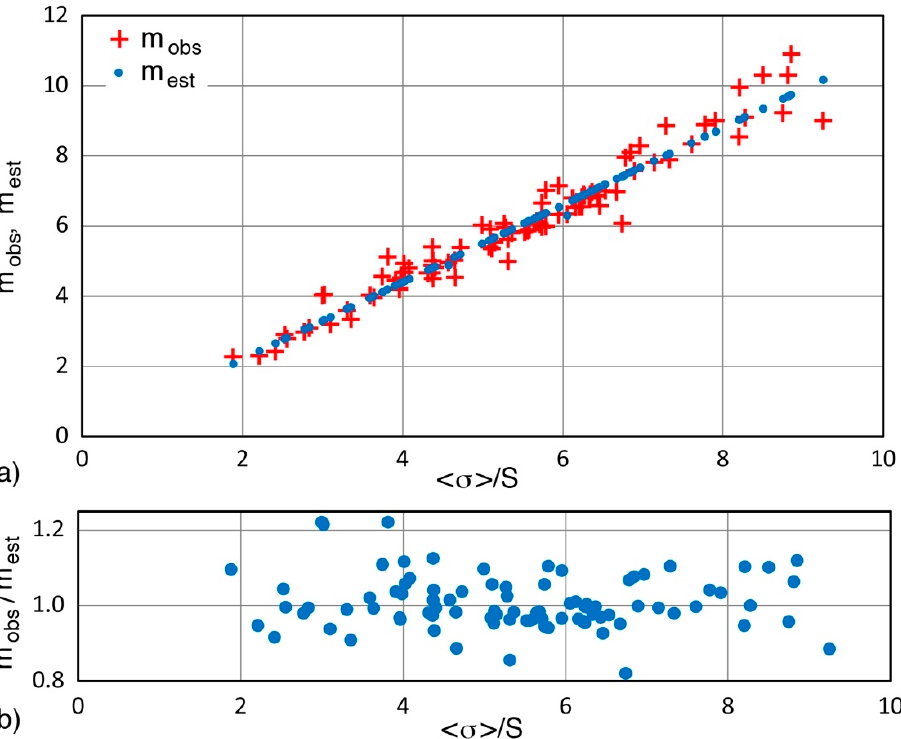
Figure 7. ( a ) Plots of m obs (red + symbol) and m est (blue dot) vs. < σ >/ S for fiber data. ( b ) Plot of m obs / m est (blue dot) vs. < σ >/ S for the same.